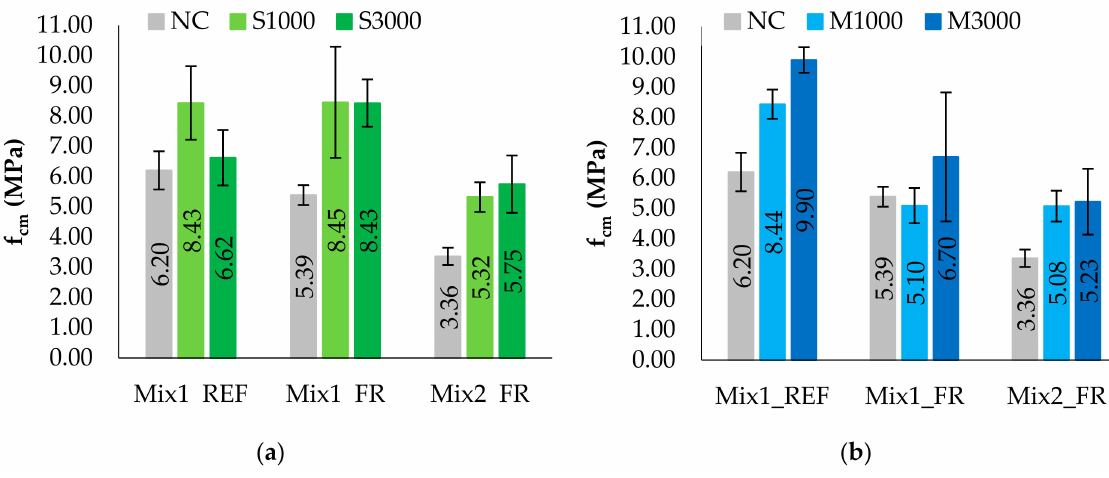
Figure 12. Compression strength of NC and C specimens: ( a ) saline environment, ( b ) moisture